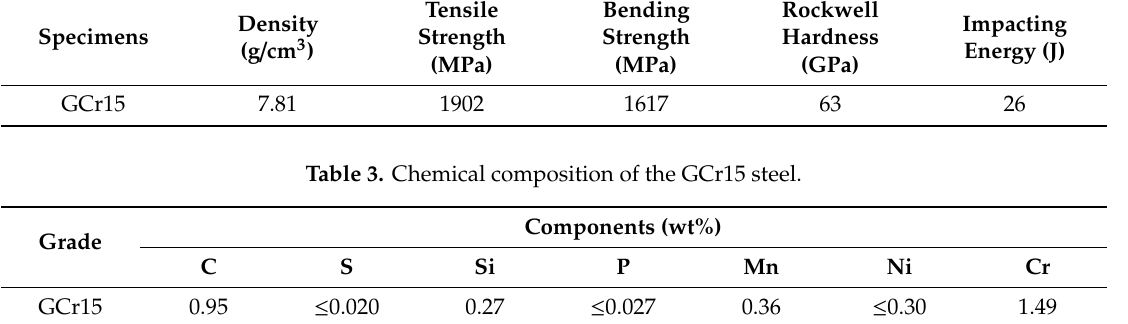
Table 2. Physical and mechanical properties of the GCr15 steel [28].